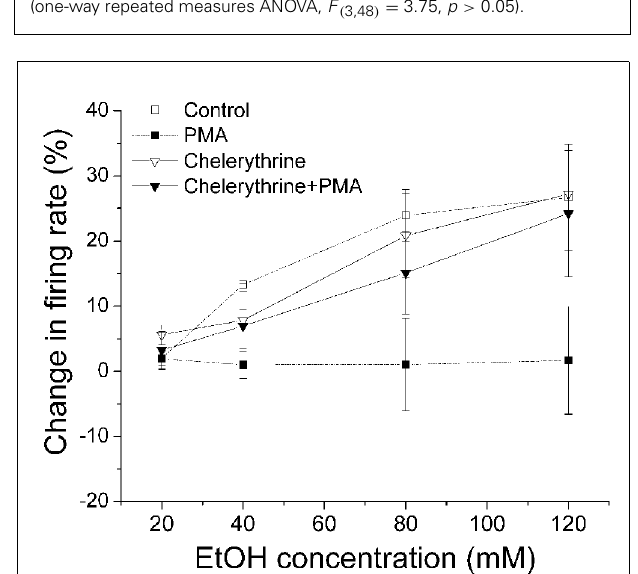
PKCs. Ethanol did produce a dose-dependent increase in fir- ing rate when Gö6976 alone was included in the pipette ( ∇ , n = 11; one-way repeated measures ANOVA, F ( 3,12 ) = 8.03, p <